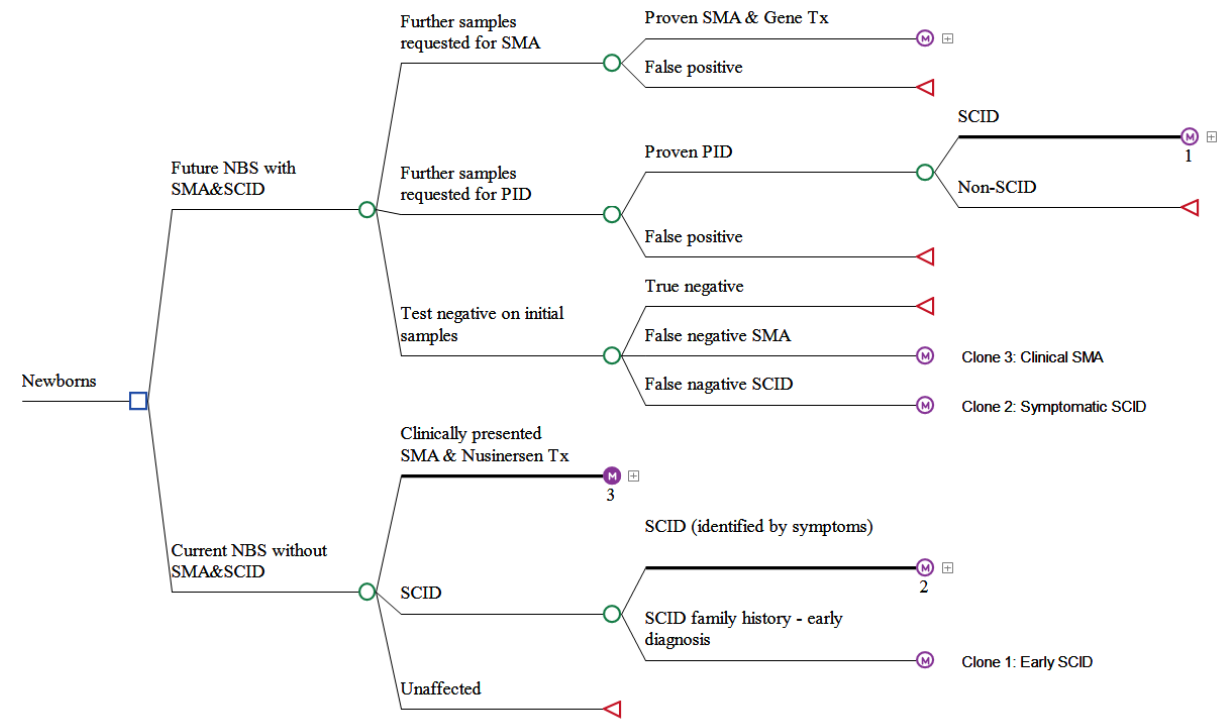
Figure 2. Schematic presentation of the decision analytical model comparing future NBS program adding combined SMA and PID with current NBS program without SMA and PID.